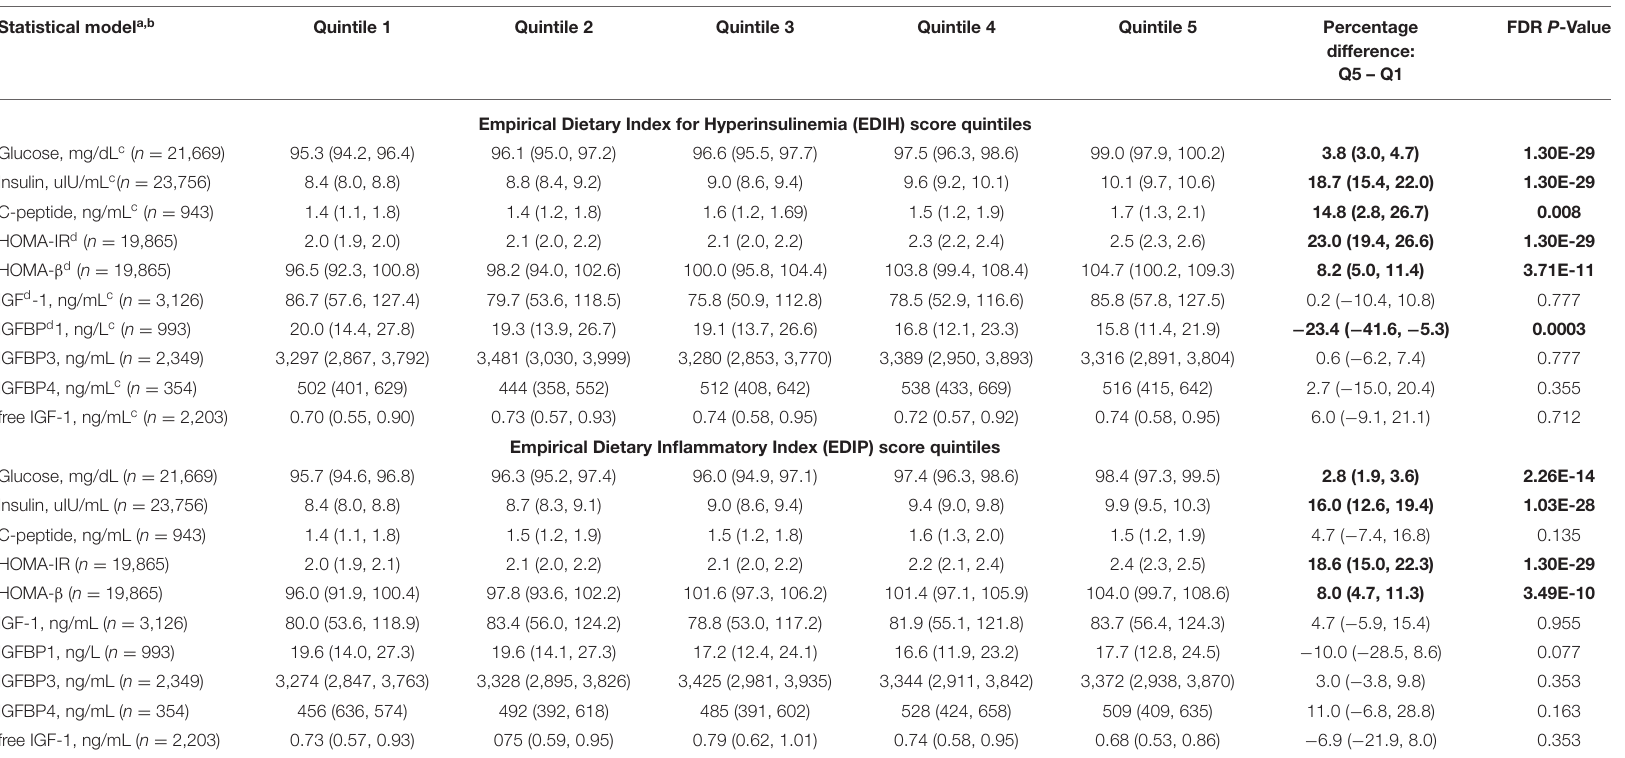
FDR P -Value difference: Q5 – Q1